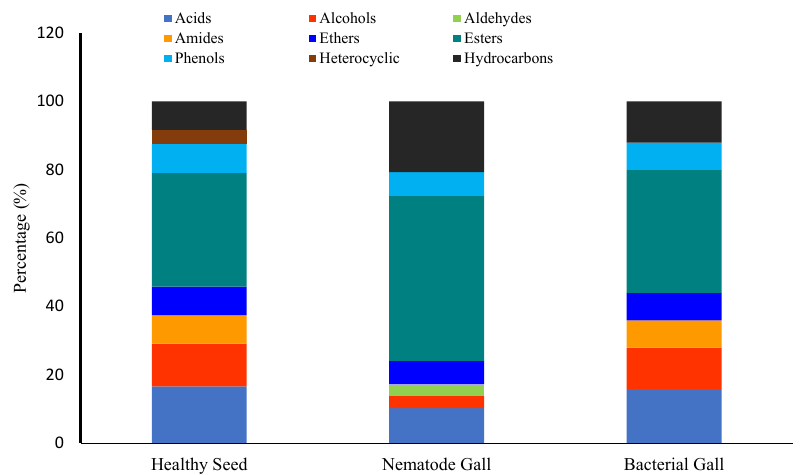
Figure 6. Ratios of chemical groups expressed in each treatment. Percentage is the ratio of the number of compounds of each group to the total number of compounds.